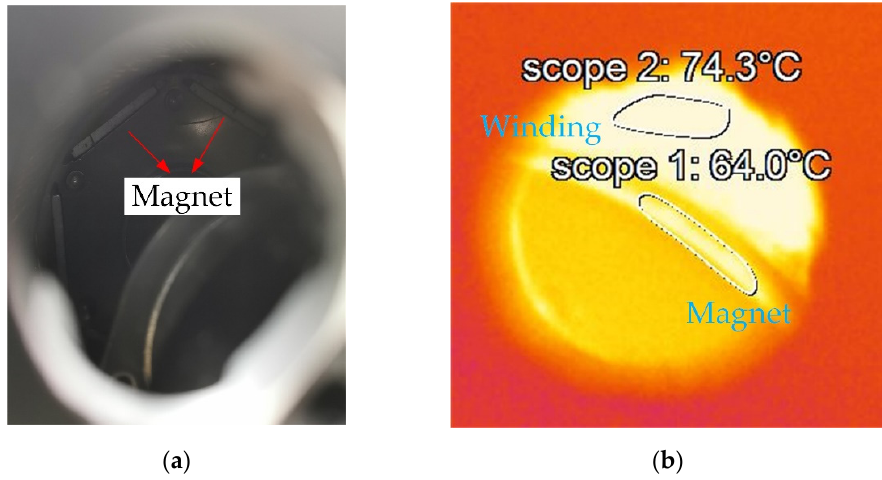
Figure 9. PM temperature measurement. ( a ) Observation hole in end cover of PMSM; ( b ) thermal image captured by a high-precision infrared thermal imager.